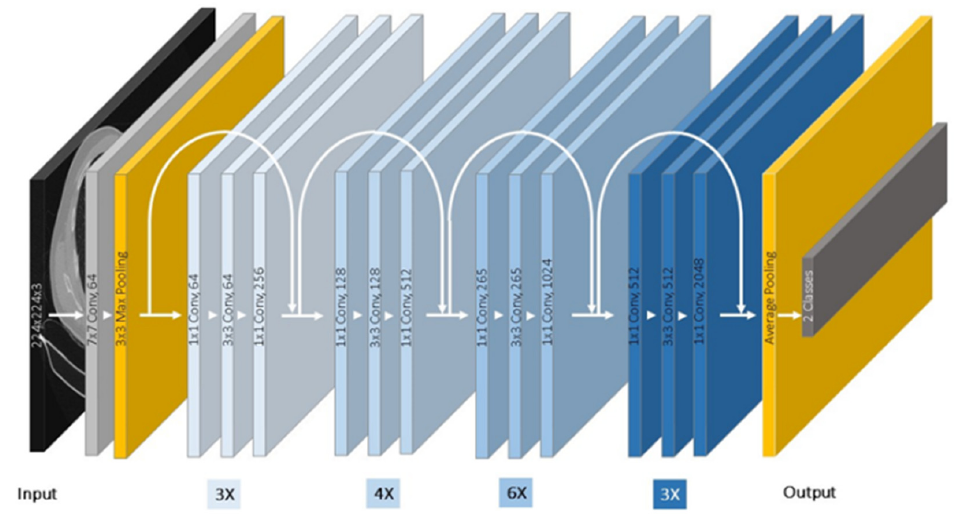
Figure 3. ResNet-50 Architecture of this research.